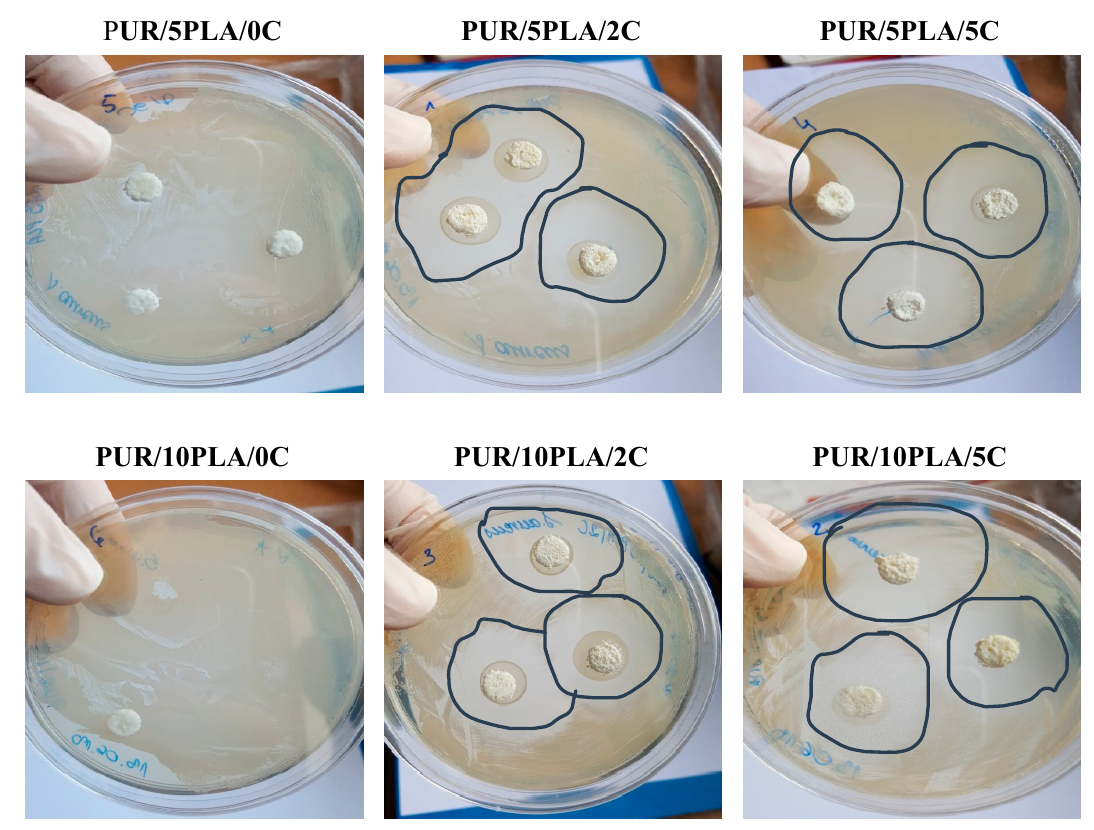
Figure 9. The effect of antimicrobial activity of Cipro-modified HPPS (2 or 5 wt % of ciprofloxacin) against S. aureus . Table 3. S. aureus inhibition zones detected for unmodified and Cipro-modified